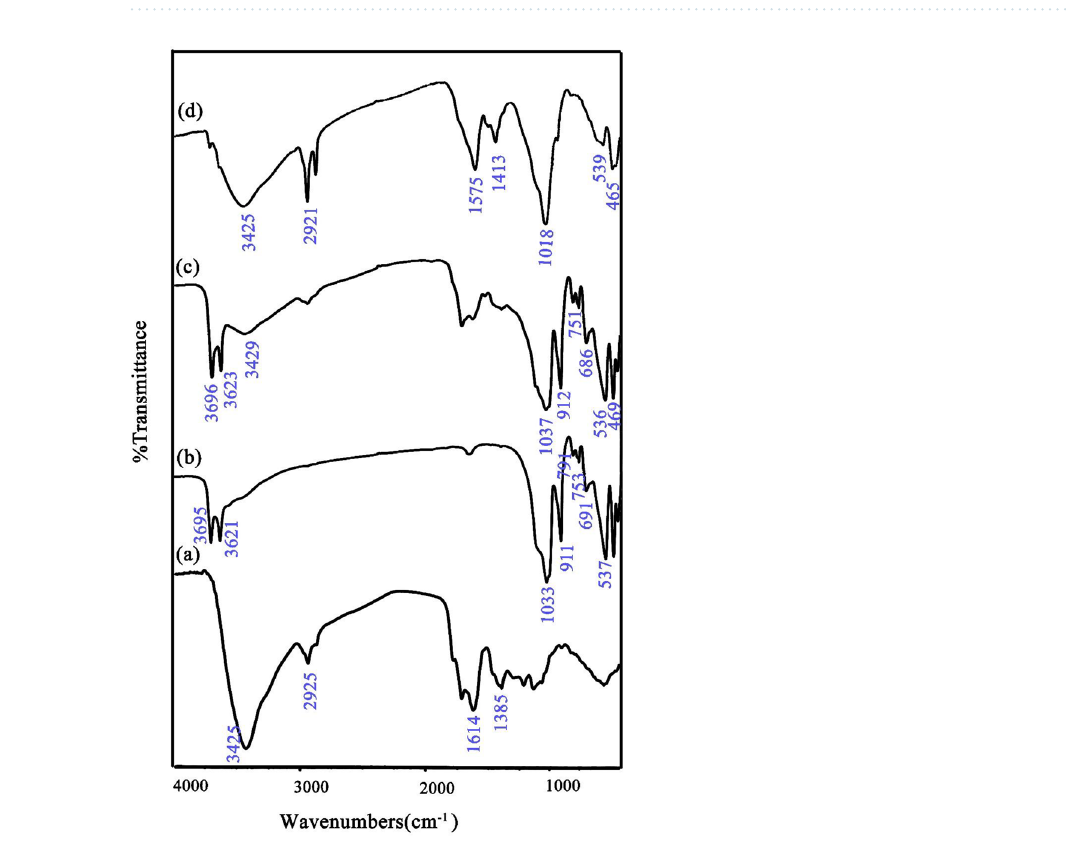
Figure 5. ( a – d ) TEM images of CoFe 2 O 4 /S, N-GQD/HNT nanocomposites at different magnifications.